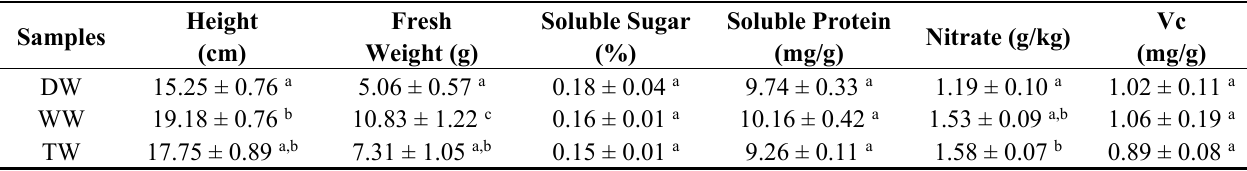
Table 4. Quality parameters of pakchoi following irrigation with DW (control), WW and TW. Samples